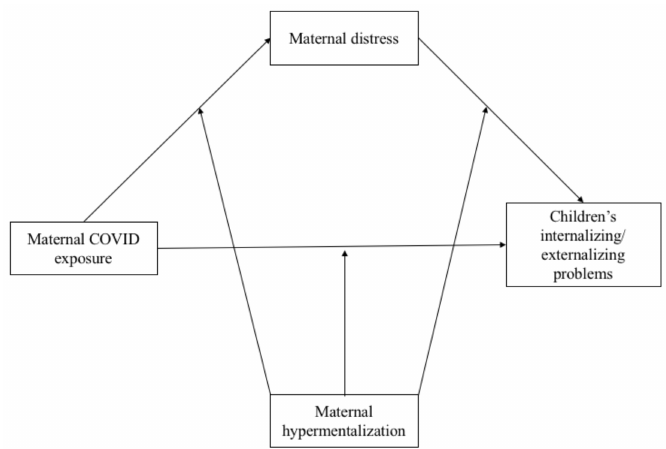
Figure 1. Theoretical Moderation Mediated Model hypothesized. Note: Each model includes children’s age, gender, and the family size as